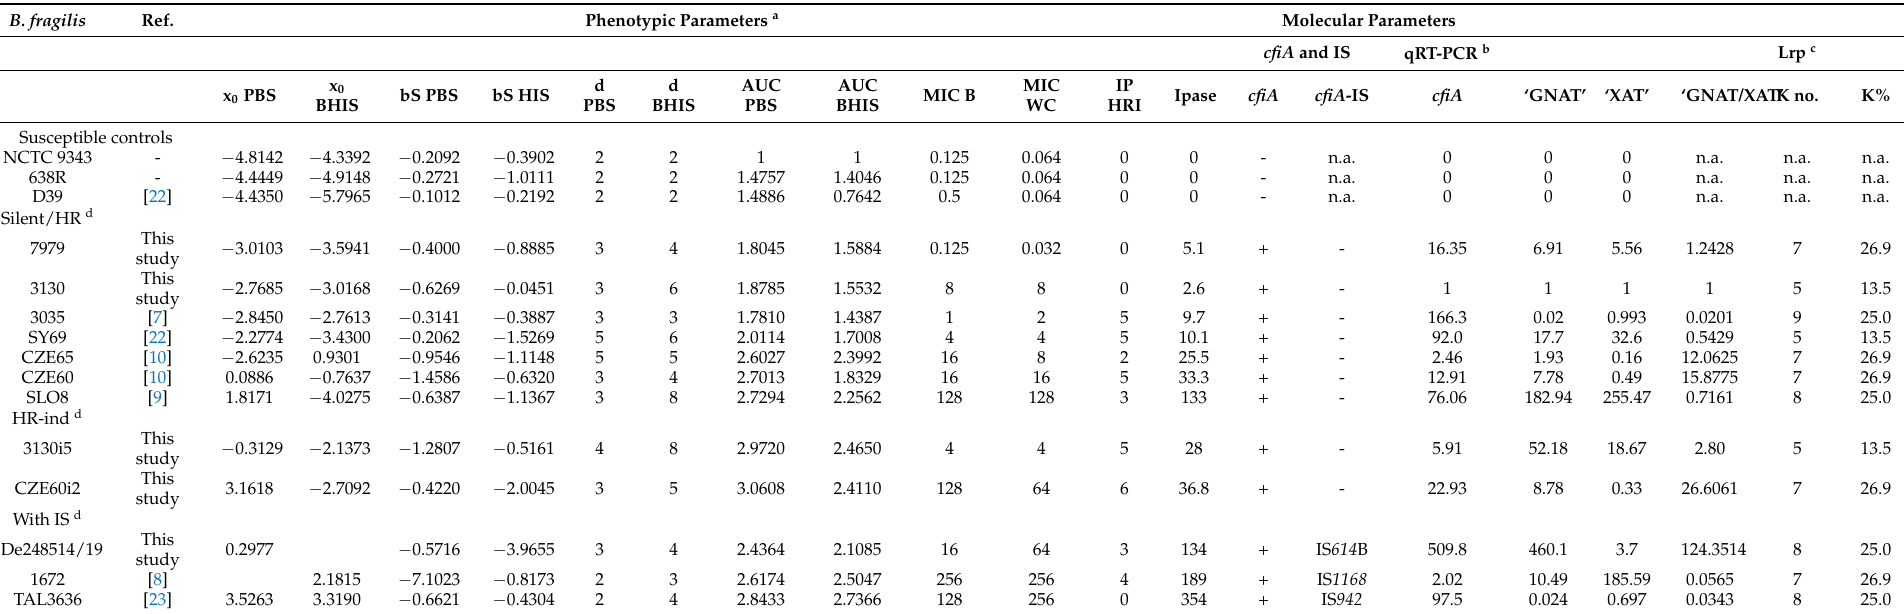
Table 1. List of strains, recorded data on imipenem susceptibilities, PAP profiles, imipenemase production and molecular